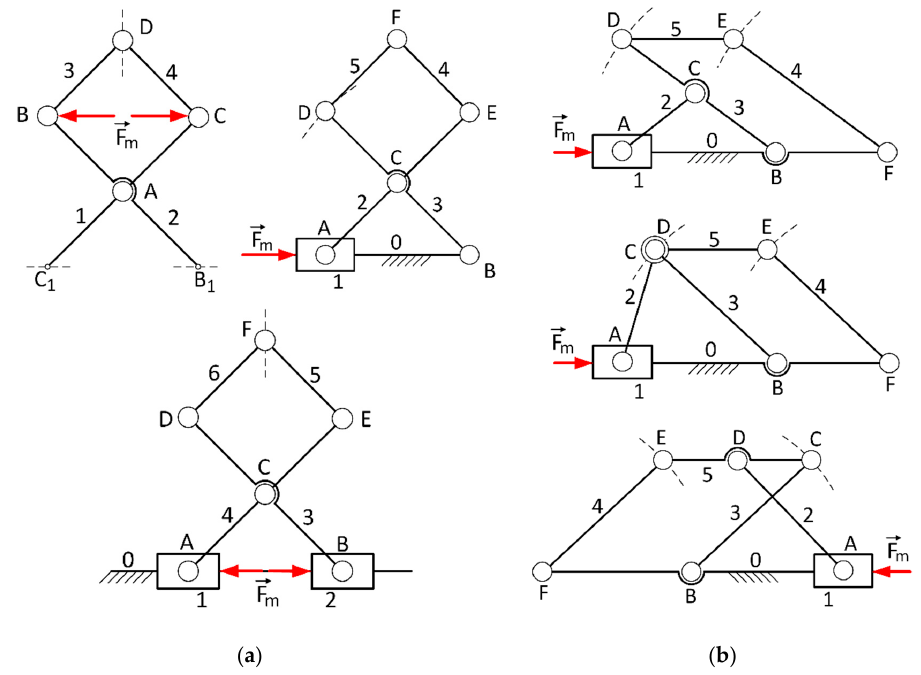
Figure 2. Linkages used for adapting mechanisms: ( a ) pantograph-based; ( b ) combined linkages.